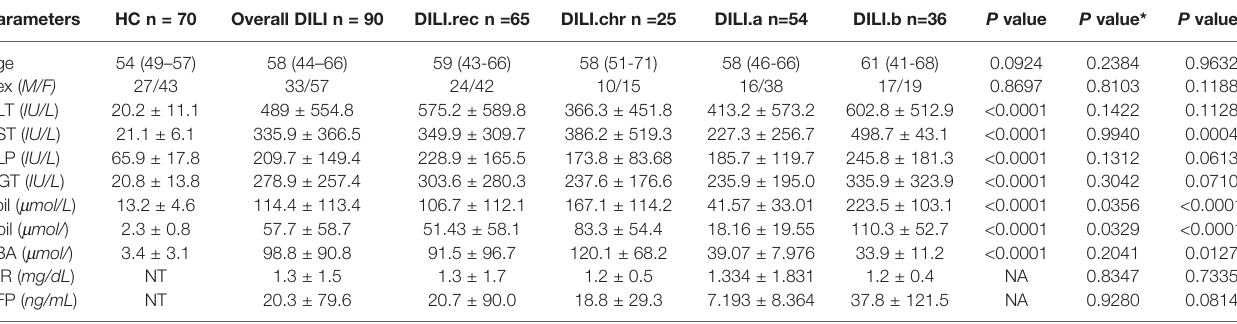
TABLE 1 | Demographics and Baseline Characteristics of Healthy Controls and DILI Patients.